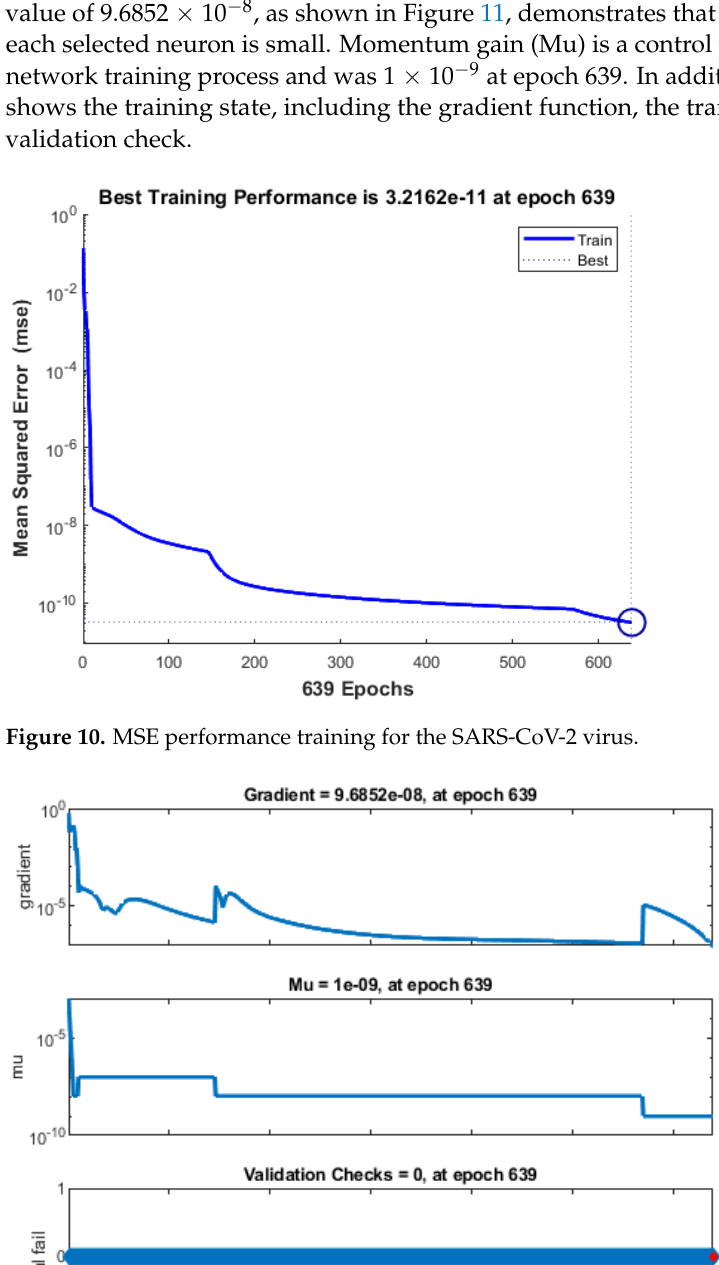
Figure 9. The responses of the target and output time series are based on training process.